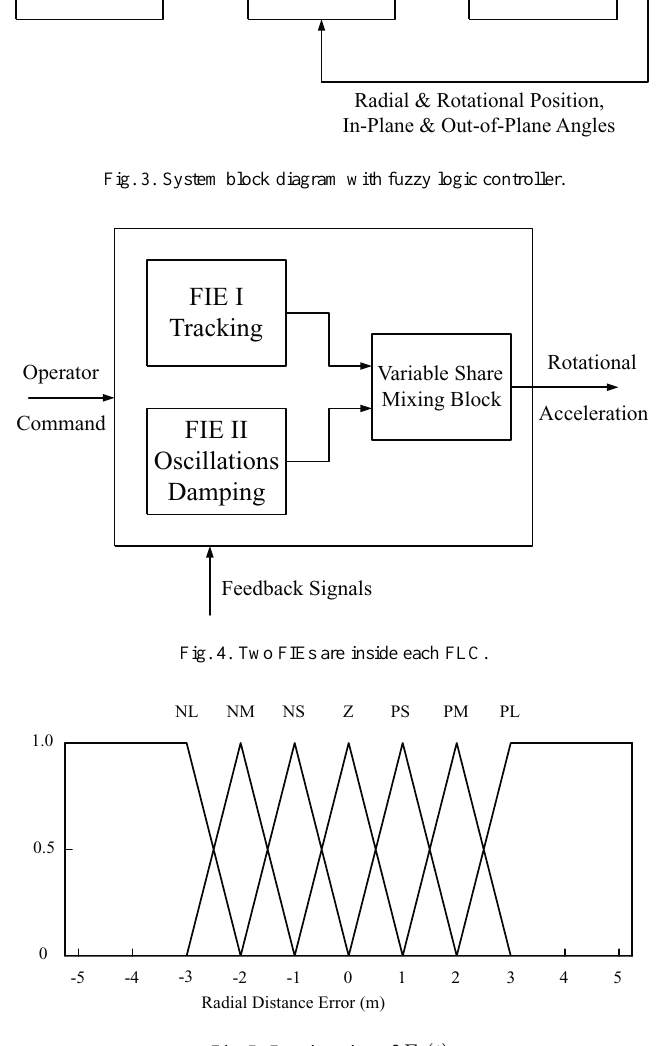
Fig. 5. Fuzzification of E r ( t )